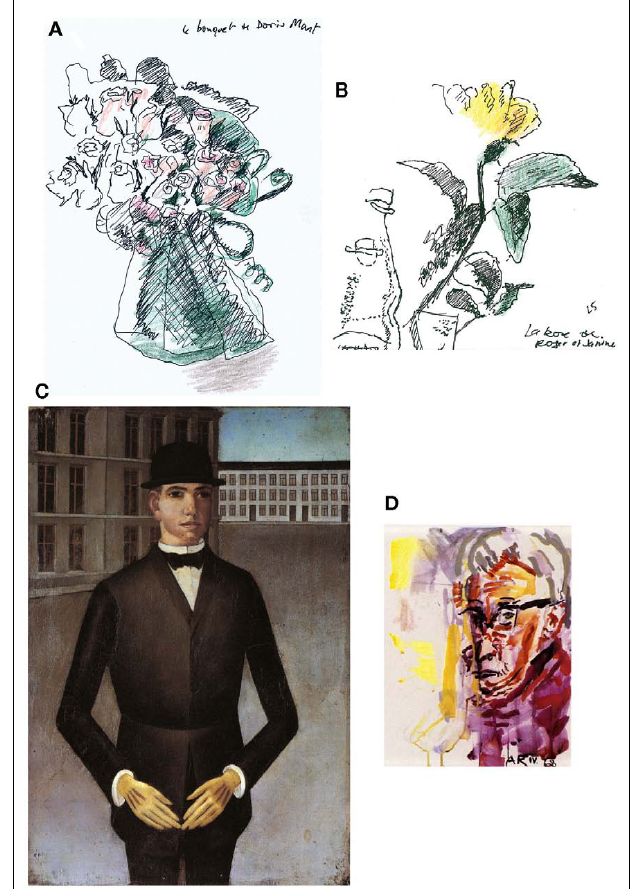
FIGURE 3 | Bouchardy-Rey andAnton Räderscheidt. (A) Huguette Bouchardy-Rey: Bouquet de Doris Mart (2001). © Huguette Bouchardy-Rey. (B) Huguette Bouchardy-Rey: Rose (2001). © Huguette Bouchardy-Rey. (C) Anton Räderscheidt. Mann mit gelben Handschuhen (1918); (D) Anton Räderscheidt. Self-portrait (1968). © Anton RäderscheidtVG Bild-Kunst, Bonn, Reproduktion aussschliesslich mit Autorisierung der Copyright-Inhaber, © 2011, ProLitteris,